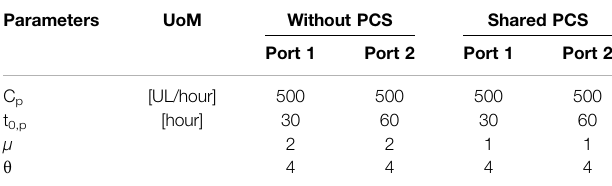
TABLE 1 | Parameters of the supply model ( Eq. 4.1 ) in the two “ tech ” scenarios. Parameters